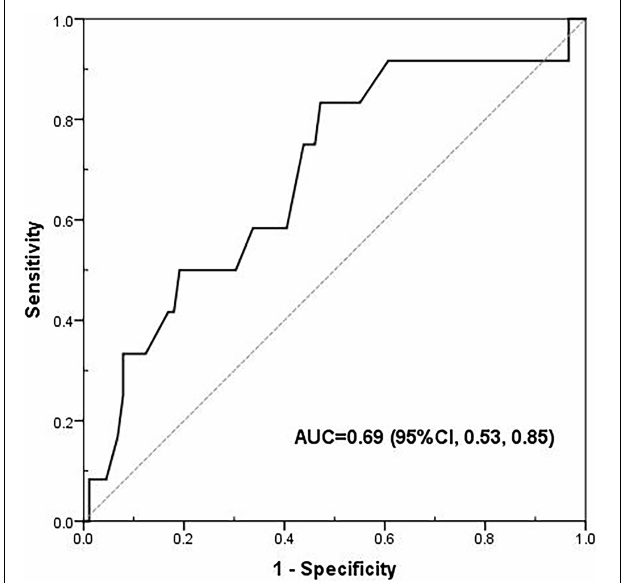
FIGURE 1 | The receiver operating characteristic (ROC) curve of phase angle for 90-day mortality. The area under the ROC (AUROC) was 0. 69 (95% CI: 0.53–0.85, p < 0.05), and the cut-off value of phase angle was 3.00 ◦ , with a sensitivity and specificity of 83 and 53%,